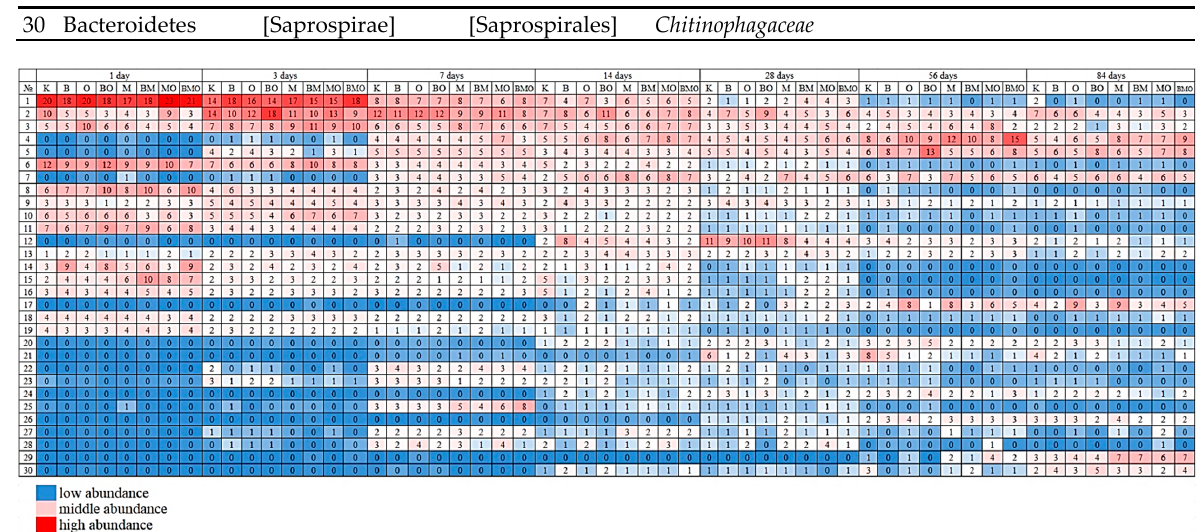
Figure 5. The dynamics of dominant OTUs in the compost mixtures during the composting process.